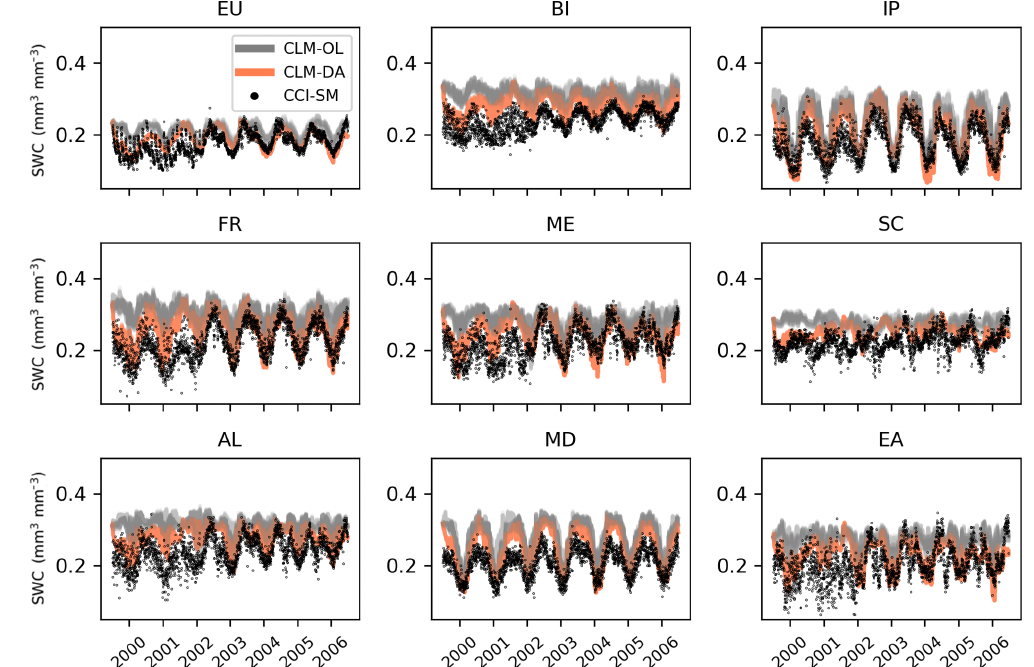
Figure 6. Spatially averaged daily soil water content (SWC) simulated with CLM-DA and CLM-OL and compared with CCI-SM data for the years 2000–2006 over Europe and the PRUDENCE regions. The orange and gray lines are the CLM-DA and CLM-OL for 20 ensemble members,